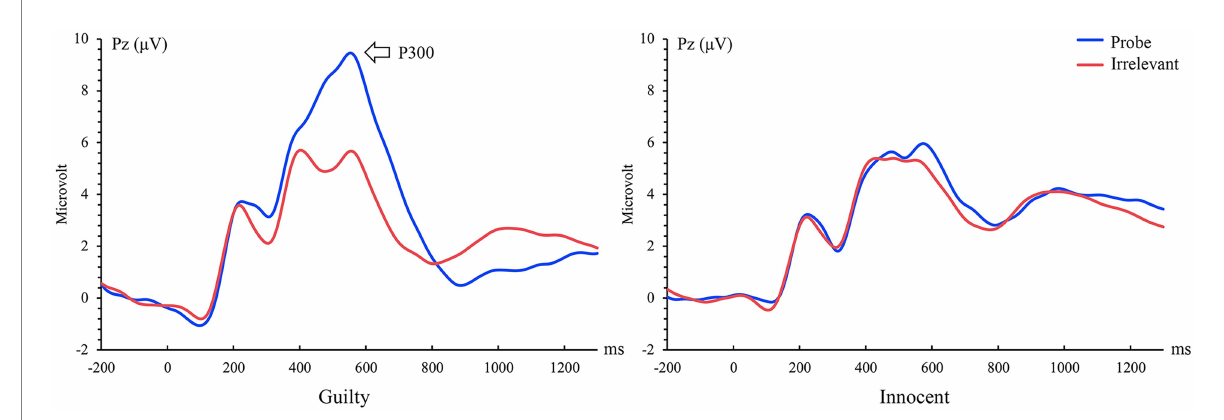
FIGURE 2 Grand-average probe/irrelevant evoked event-related potential (ERP) waveforms from